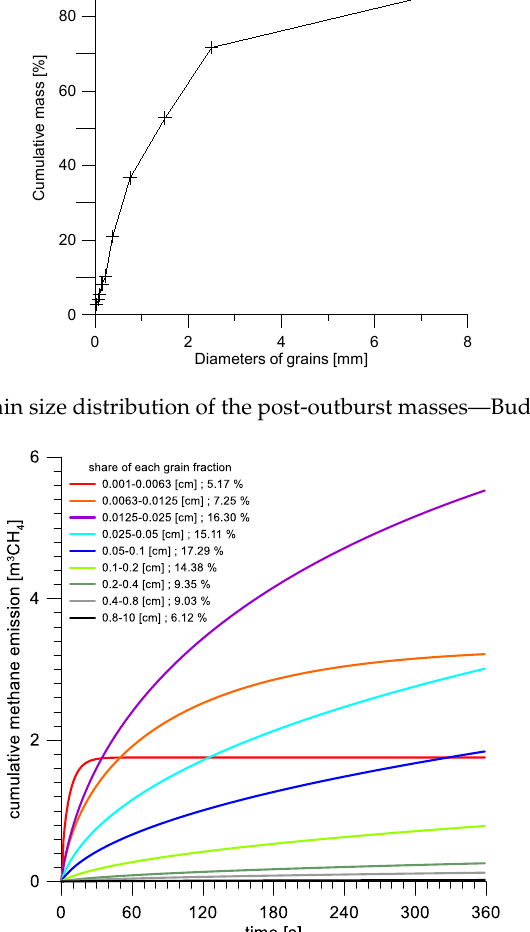
Figure 10. Methane emission during the first 6 min of the outburst from particular grain fractions— Zofiówka coal mine.